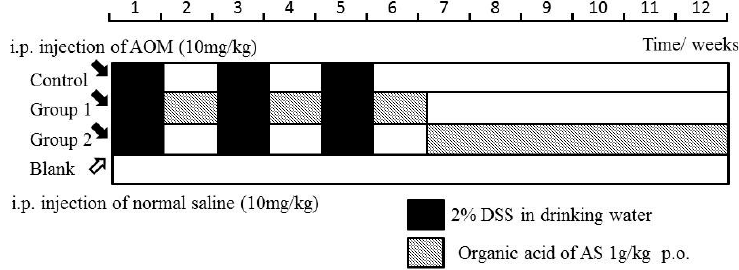
Figure 9. Experimental procedures of the Azoxymethane/Dextran sodium sulphate (AOM/DSS) model establishment and ASR extract administration.